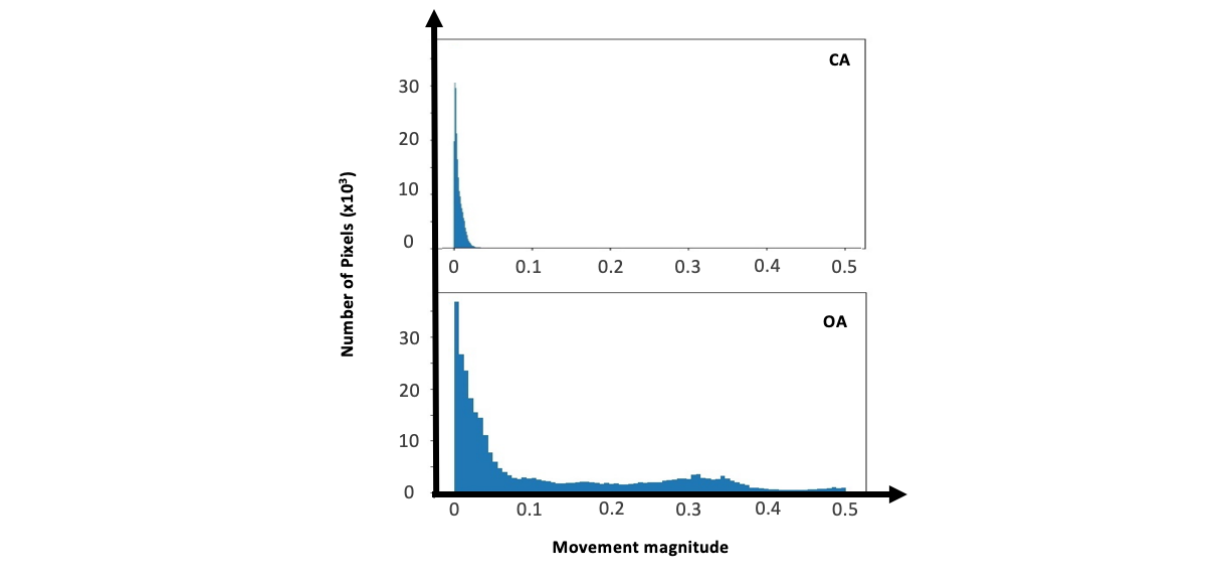
Figure 4. Histogram of movement magnitudes. Obstructive apneas have more range of motion as compared with central apneas because of the breathing effort. CA: central apnea; OA: obstructive